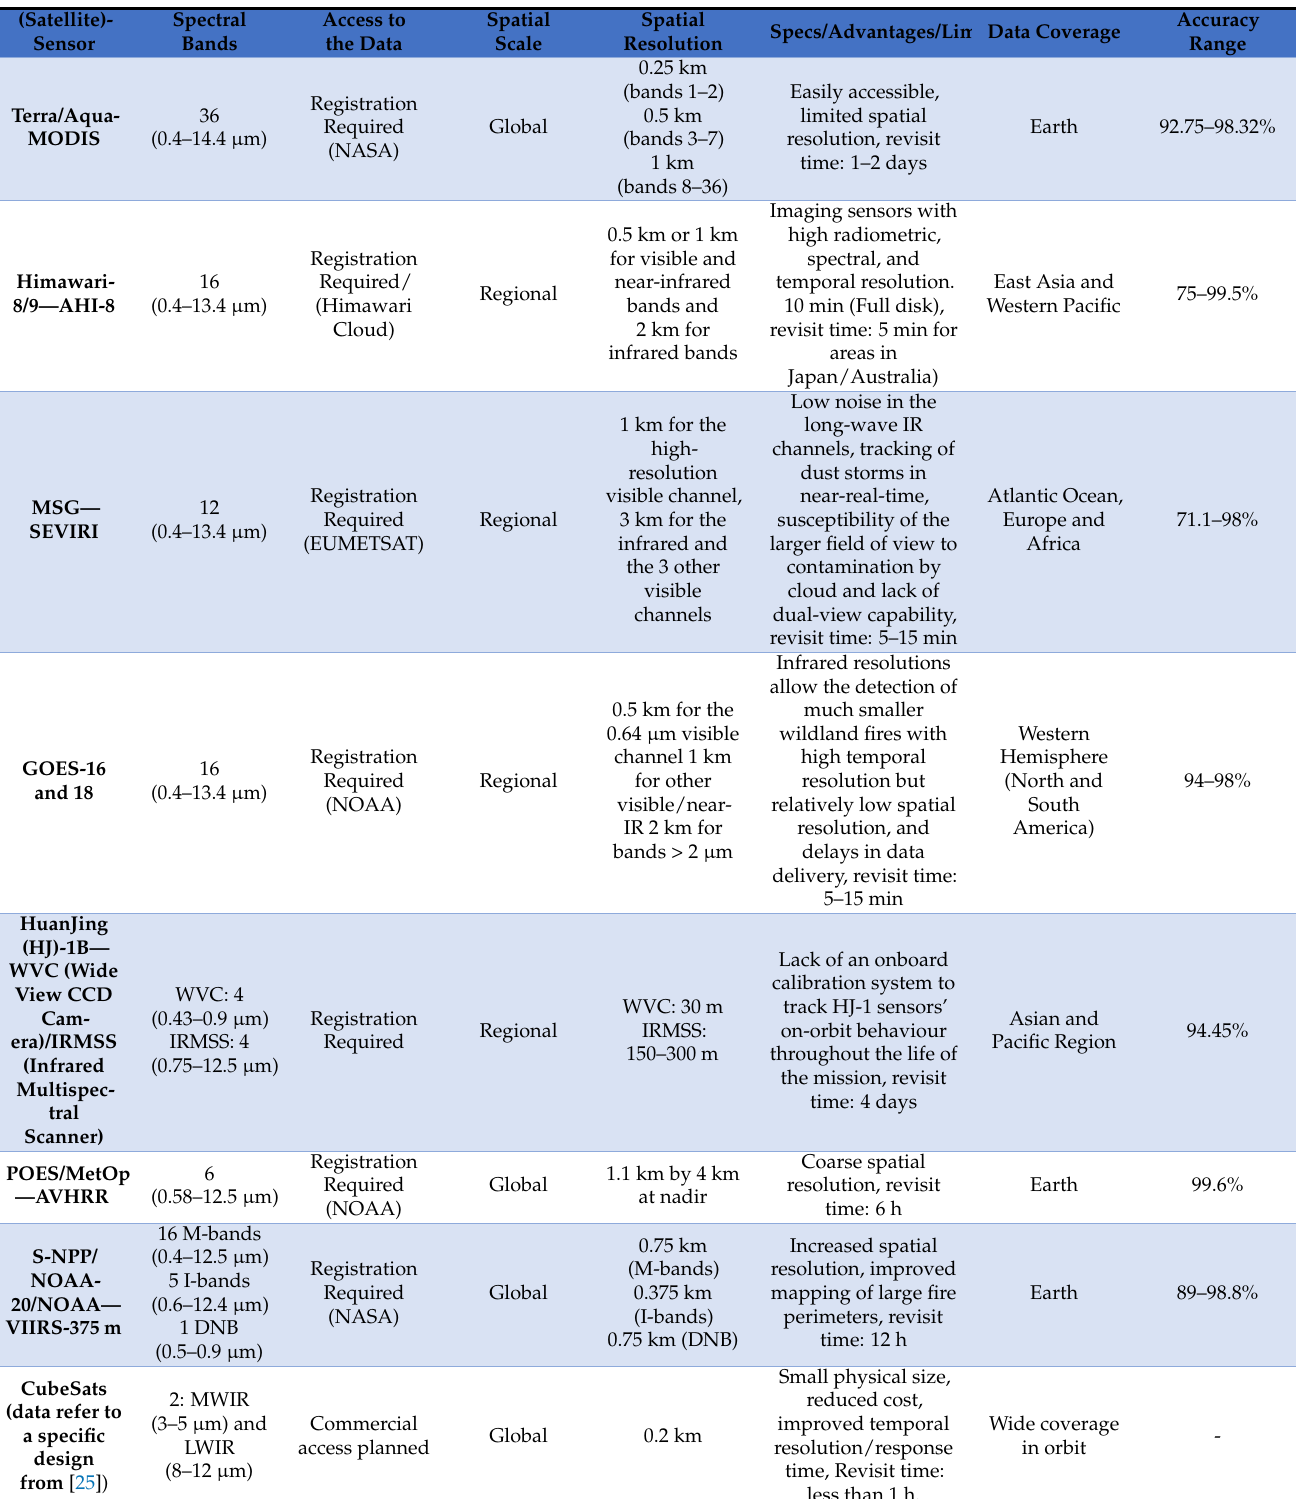
Table 2. List of some reference remote sensing satellite systems and their characteristics. Adapted from